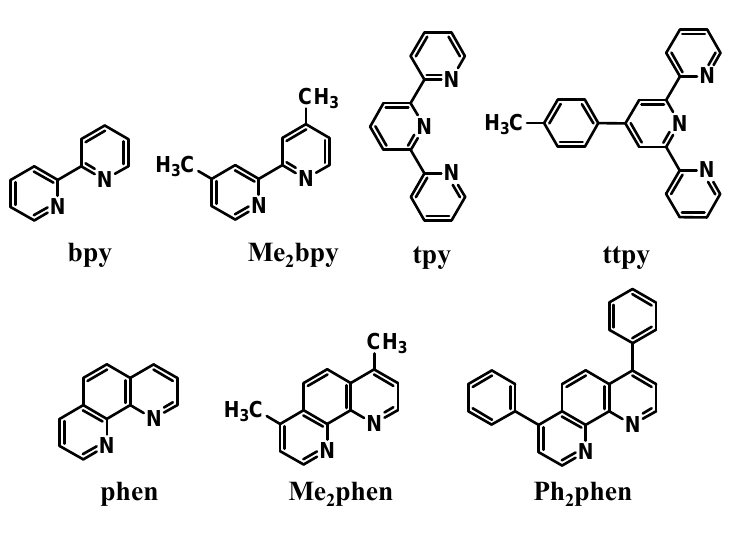
Figure 4. Polyazine terminal